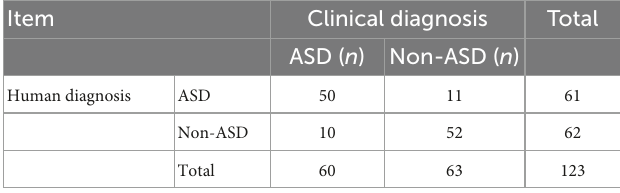
TABLE 5 Outcomes of ASD diagnosis based on the human-rated results of RTN.